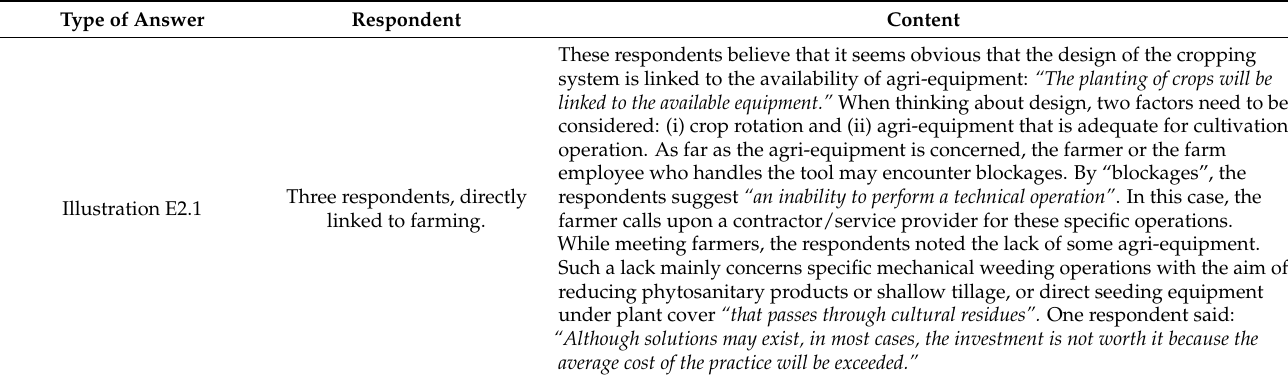
Table 3. Multiple illustrations about the links between agri-equipment and farming system